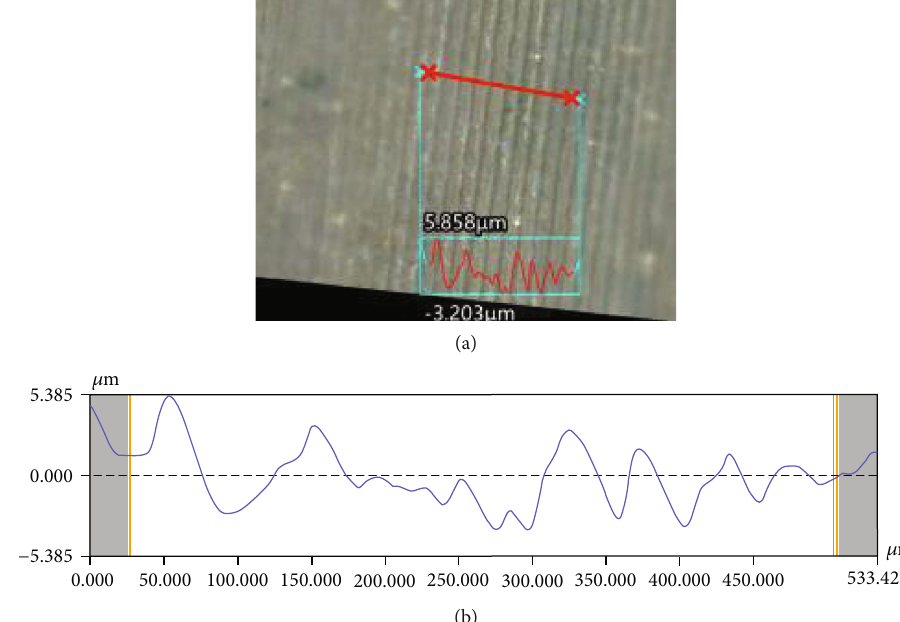
Figure 6: Scanning diagram of the contact surface contour curve. (a) Surface scanning diagram. (b) Surface roughness pro fi le curve.